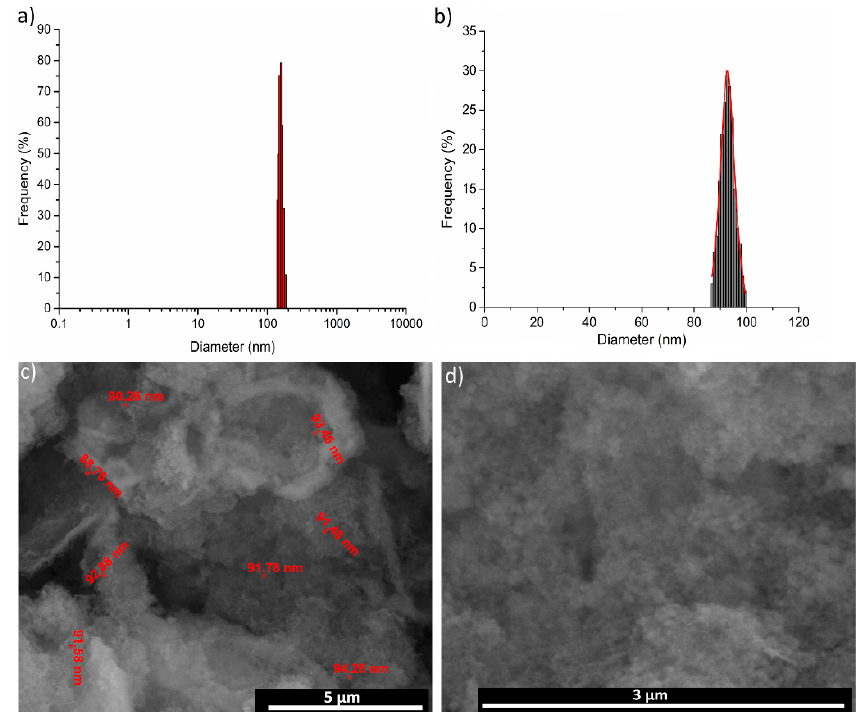
Figure 8. ( a ) The mean particle size and particle size distribution of the 10MgHAp sample, as determined by dynamic light scattering measurements. ( b ) The histogram of the particle size distribution. ( c ) scanning electron microscopy image with particle size. ( d ) Representative scanning electron microscopy image at a high magnification of the 10MgHAp nanostructured powder.